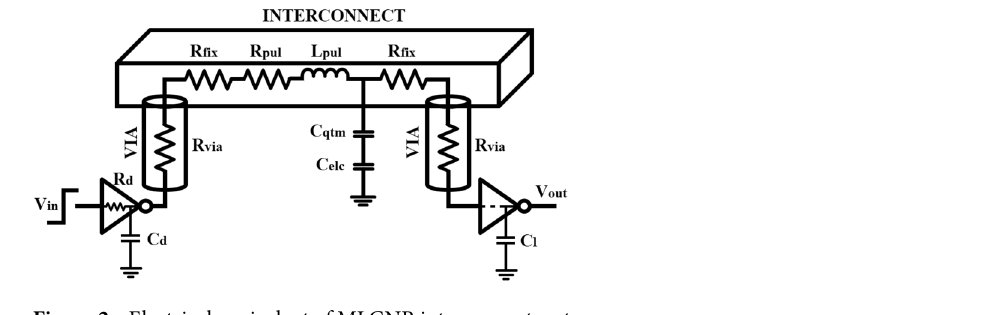
Figure 2. Electrical equivalent of MLGNR interconnect